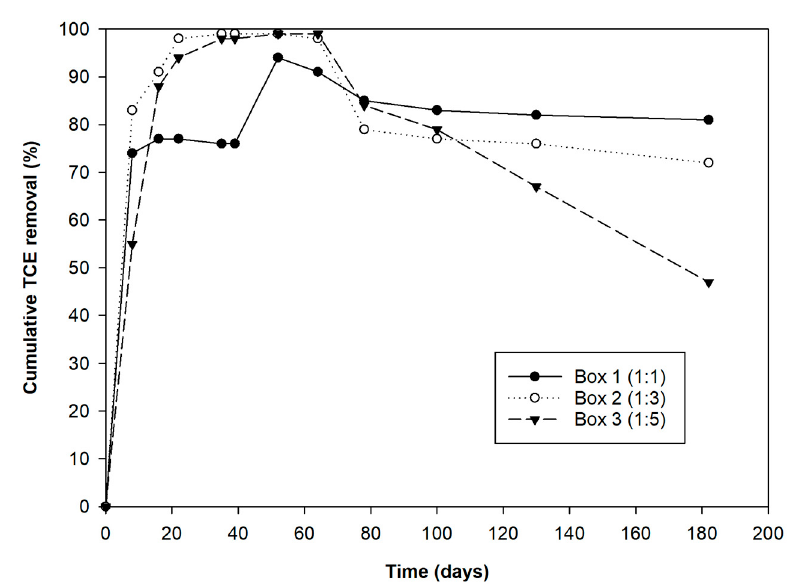
Figure 3. Cumulative trichloroethylene (TCE) removal during the time of the experiments.